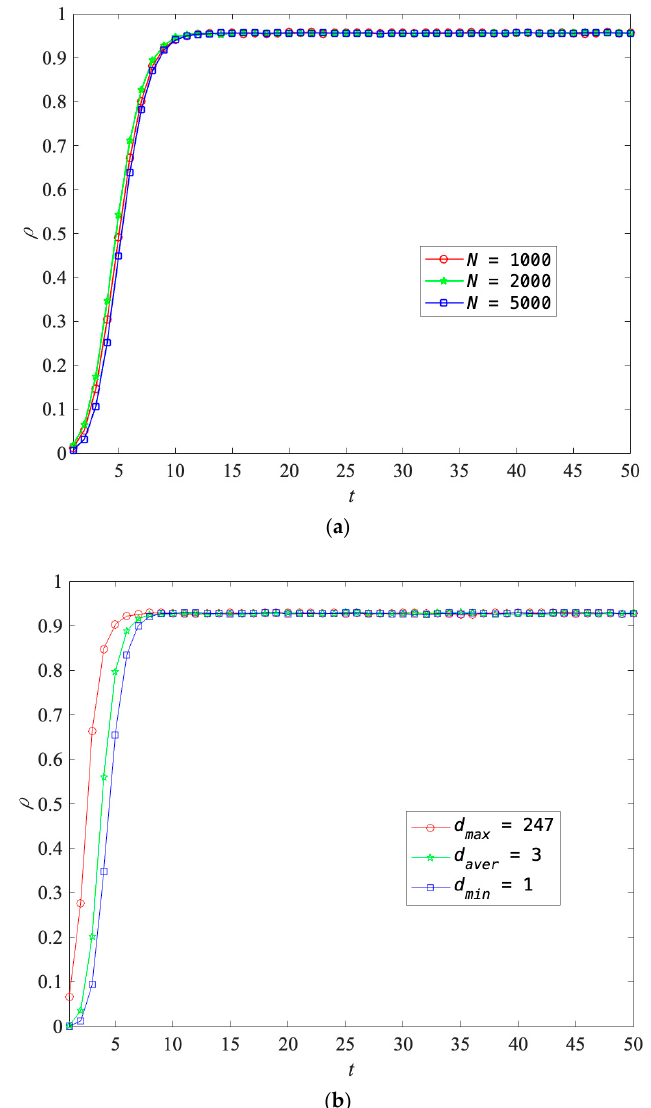
Figure 6. The simulated density of infected nodes 𝜌 vs. time 𝑡 for different hypernetwork scales ( a ) and initial spreading seed ( b ).